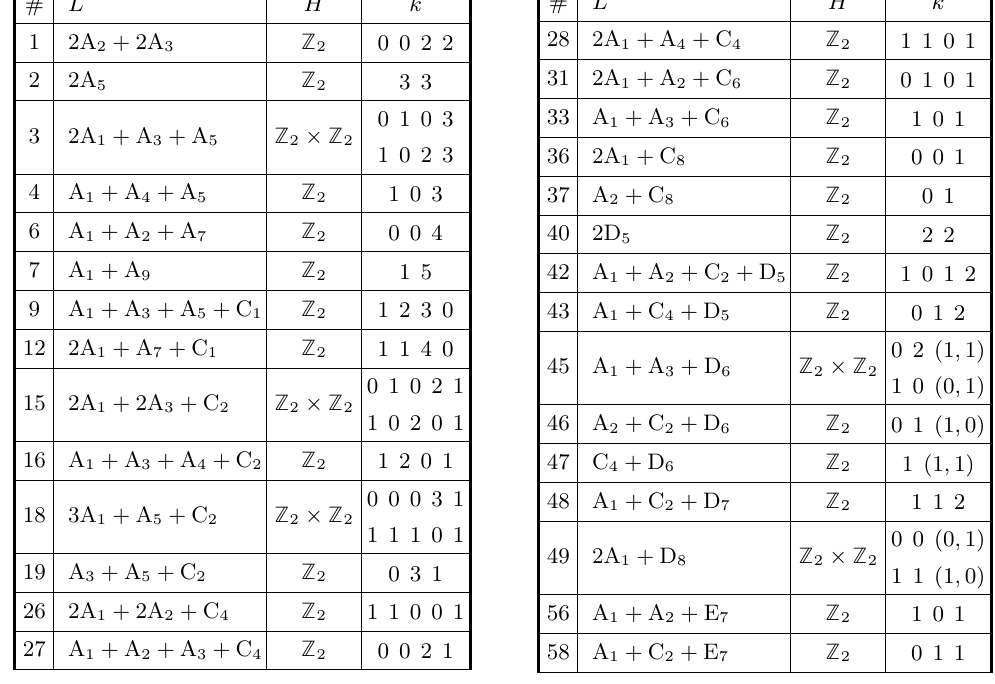
Table 6 . Maximal enhancement groups with non-trivial global structure for the 8-dimensional CHL string. The k ’s are the generators of H . All ADE groups arise at level 2 while C groups arise at level 1